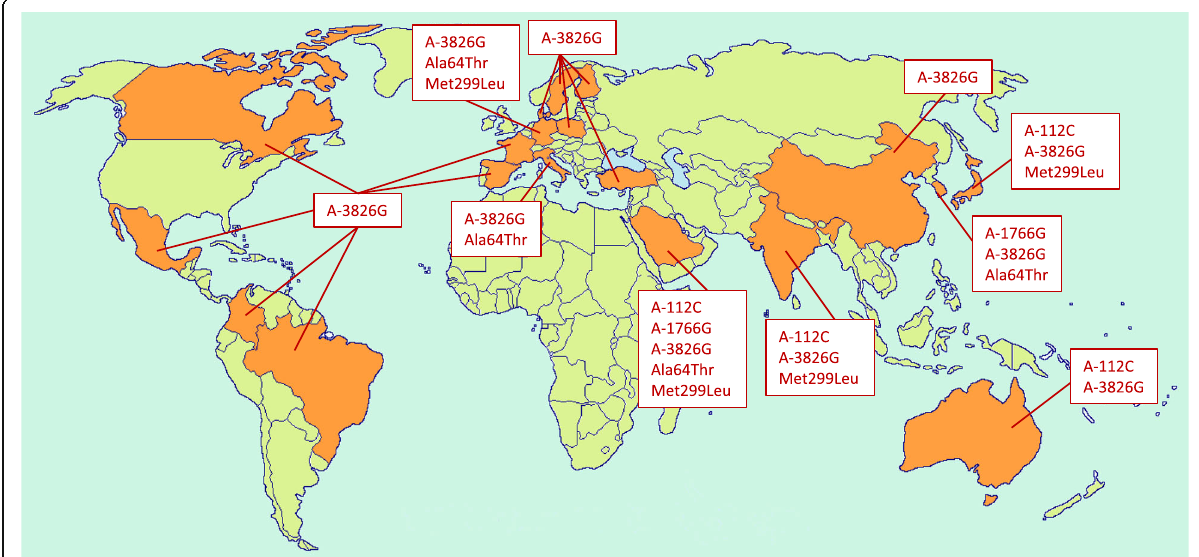
Fig. 1 World map showing the investigation of the association of Ucp1 polymorphisms with CMDs or CMD risk